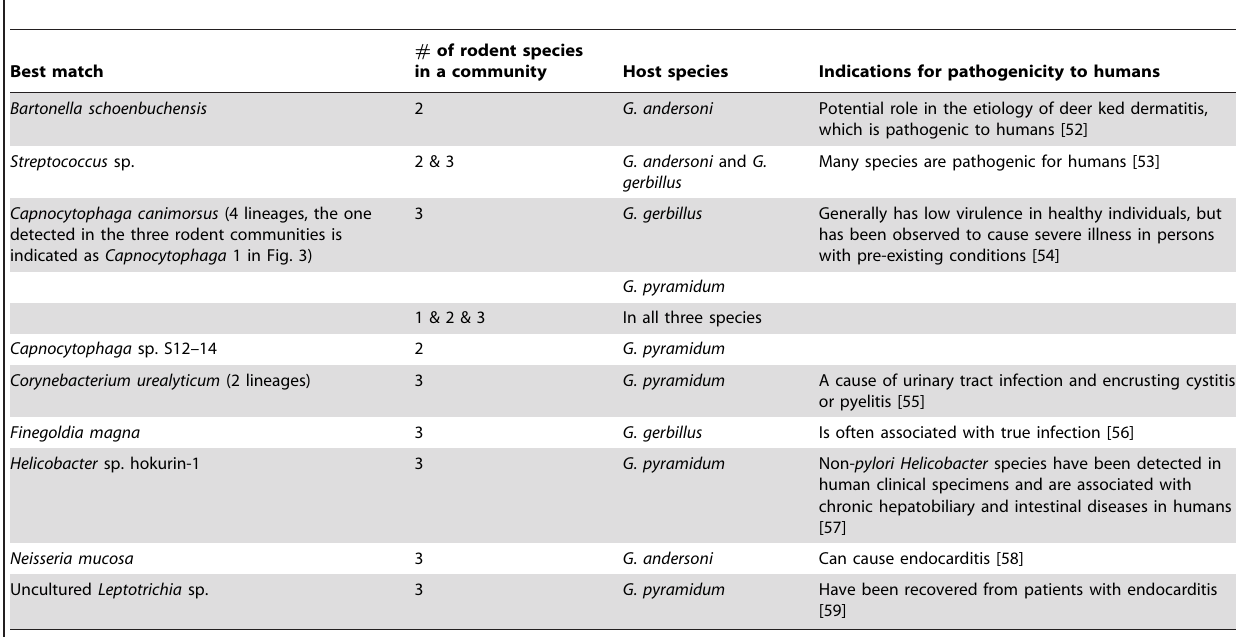
Table 1. Bacterial lineages suspected to be zoonotic pathogens and the host species and rodent community in which they were